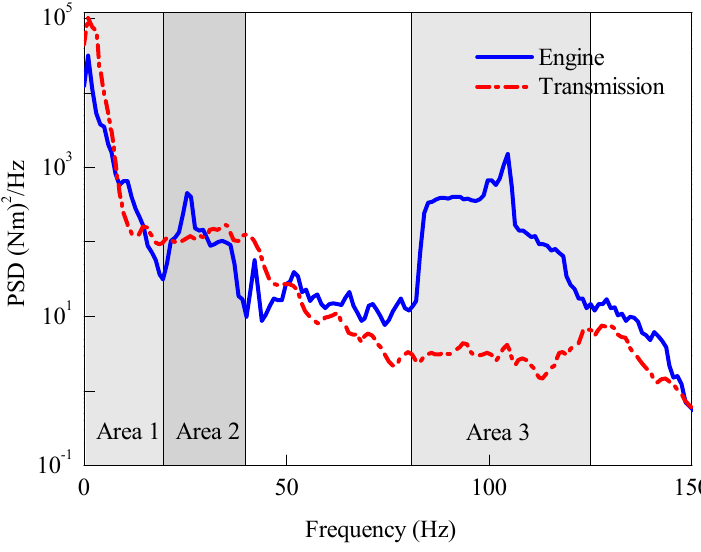
Figure 5. PSD analysis of torque on the engine and transmission output shaft.